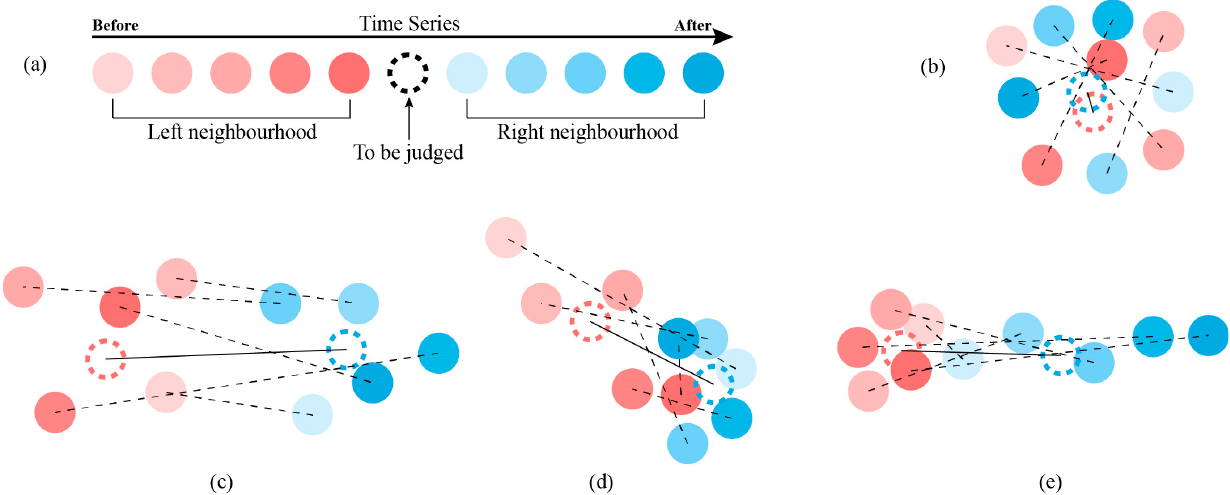
Figure 9. The algorithm principle of stationary segment recognition. ( a ) The coordinates of the same marked point in time series. ( b ) The coordinate series in stationary status. ( c ) The coordinate series in motive status. ( d ) The coordinate series when the marked point is about to stop. ( e ) The coordinate series when the marked point is about to move.